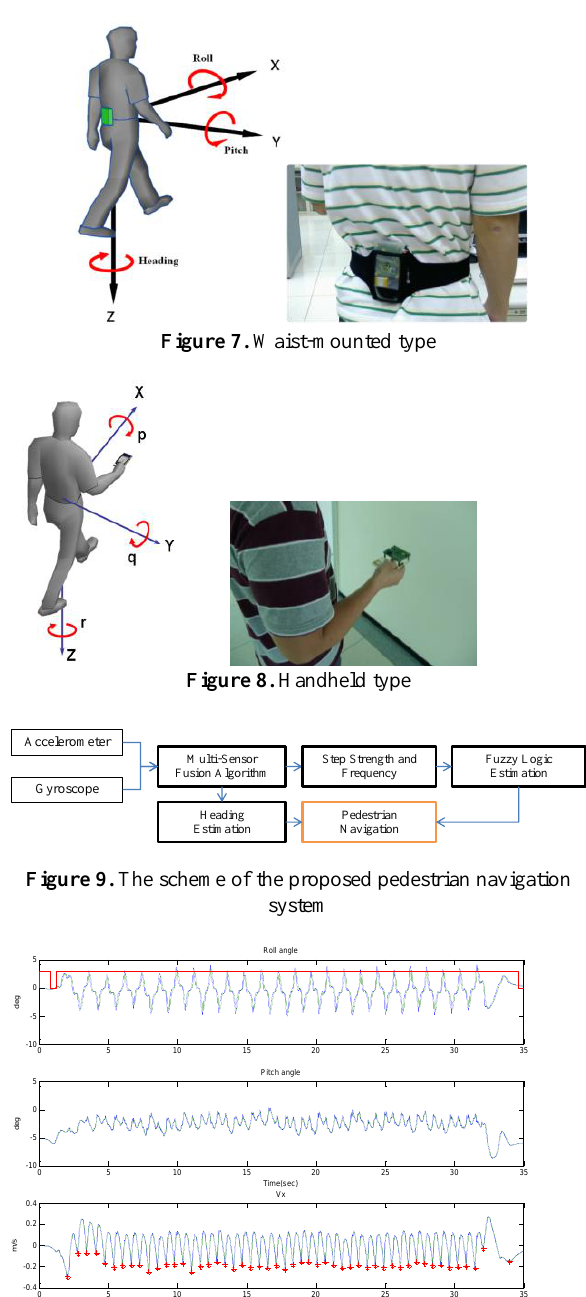
Figure 11. The roll and pitch angles from different